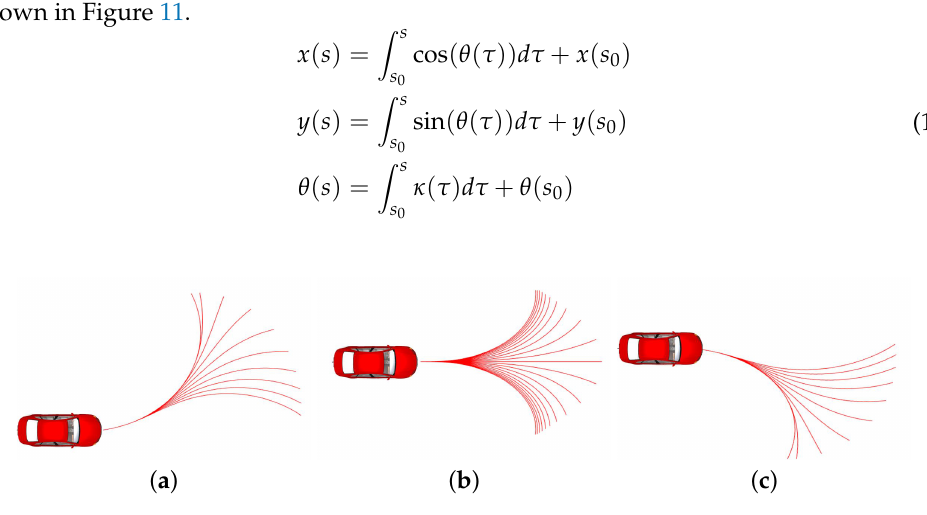
Figure 11. The reachable set with different initial curvature κ 0 . ( a ) κ 0 > 0. ( b ) κ 0 = 0. ( c ) κ 0 < 0